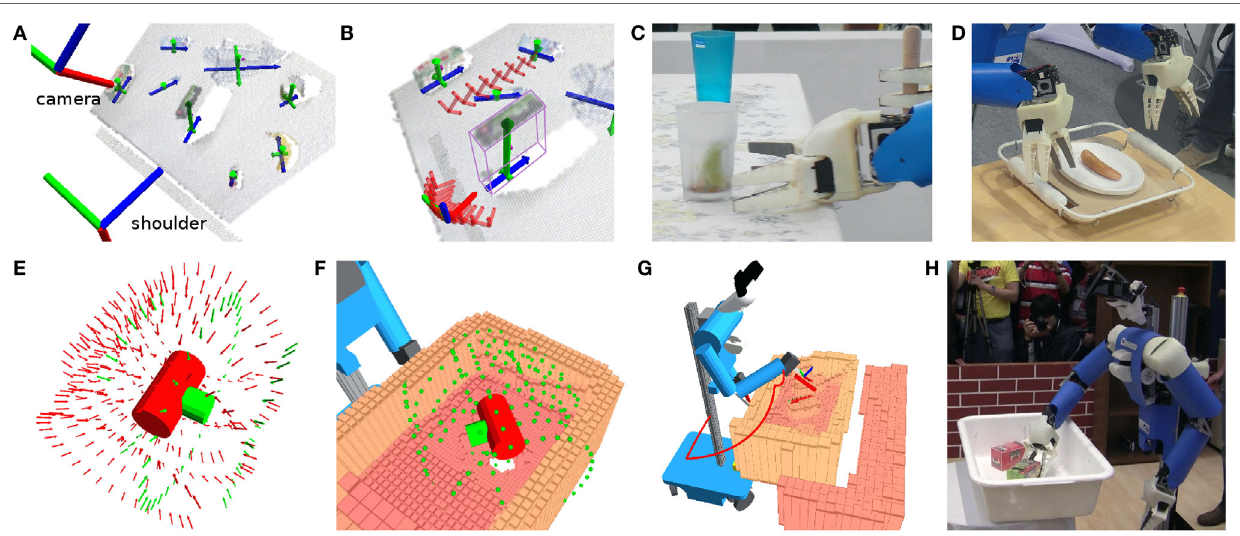
FIgURe 10 | grasp and motion planning . (A) Object shape properties. The arrows mark the principal axes of the object. (B) We rank feasible, collision-free grasps (red, size proportional to score), and select the most appropriate one (large, RGB-coded) (Stückler et al., 2013b). (c) Example side grasp. (D) Example top grasp; motion planning for bin picking (Nieuwenhuisen et al., 2013): (e) Grasps are sampled on shape primitives and checked for collision-free approach. (F) The estimated object pose is used to filter out grasps that are not reachable or would lead to collisions. (g) Arm motion is planned for multiple segments using an object-centered local multiresolution height map (reaching trajectory in red, pre-grasp pose larger coordinate frame). (h) Bin picking demonstration at RoboCup 2012 in Mexico City (Stückler et al.,